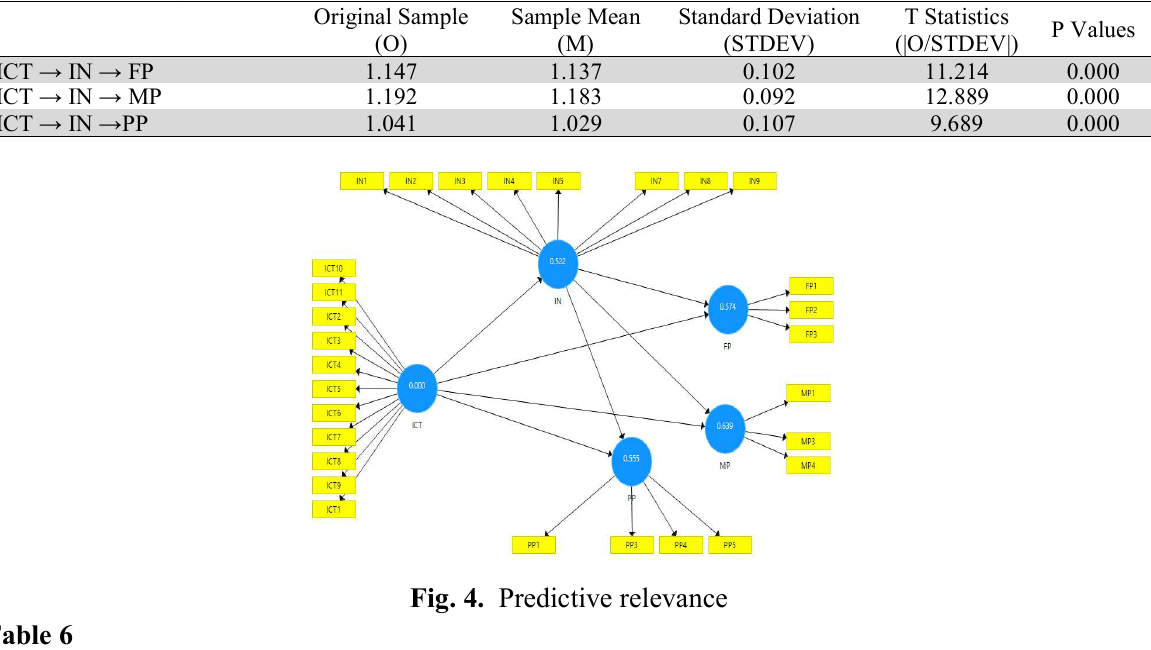
Direct relationships (Mediation )